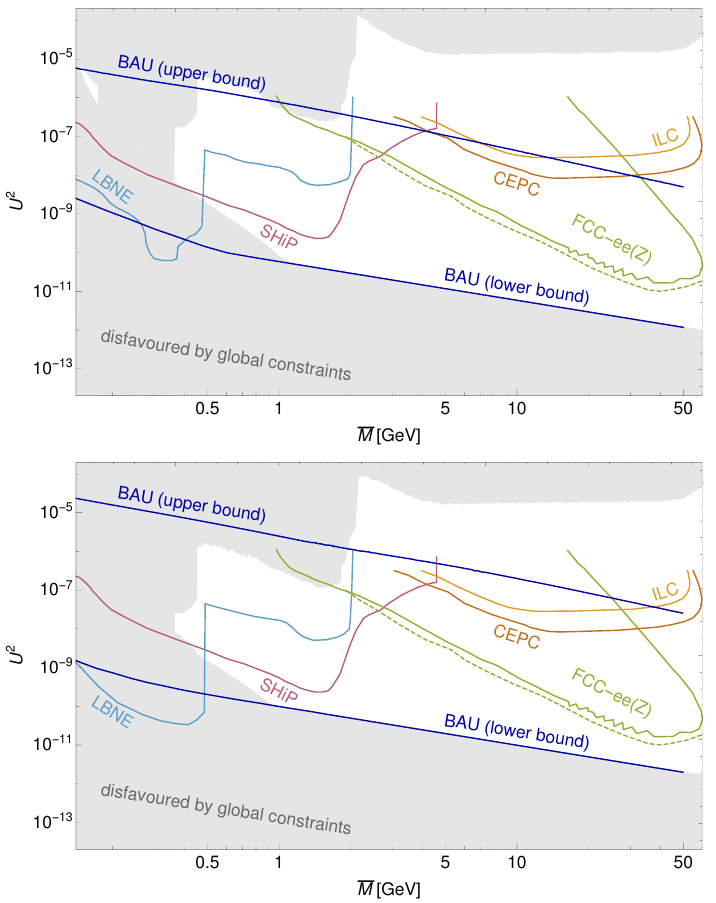
Figure 4 . Limits on the total U 2 as a function of (cid:22) M = ( M 1 + M 2 ) = 2 for normal hierarchy (top panel) and inverted hierarchy (bottom panel). The grey area corresponds to the parameter region that is disfavoured by the combined constraints discussed in subsection 2.3. The dark blue lines are the upper and lower bound of U 2 consistent with neutrino oscillation data and the requirement e to account for the observed BAU. These are compared to the sensitivity of future experiments: the SHiP lines (purple) show the 90% c.l. upper limits assuming 0 : 1 background events in 2 (cid:2) 10 20 proton target collisions for a ratio of U 2 : U 2 : U 2 (cid:24) 52 : 1 : 1 [166, 167]. The LBNE/DUNE sensitivity e (cid:22) (cid:28) (light blue) is for the assumption of an exposure of 5 (cid:2) 10 21 protons on target for a detector length of 30 m [168]. The solid FCC-ee(Z) lines (olive green) correspond to the expected reach of FCC-ee for 10 12 Z bosons with a displaced vertex at 10{100 cm [169]. The expected sensitivities at 2 (cid:27) for heavy neutrino searches via displaced vertices are presented for the FCC-ee(Z) (olive green, dashed), the CEPC (brown) and for the ILC (dark orange), each at the Z pole run for a centre of mass energy m cms = m Z [170]. It is important to point out that the ILC can potentially do much better at higher centre of mass energies